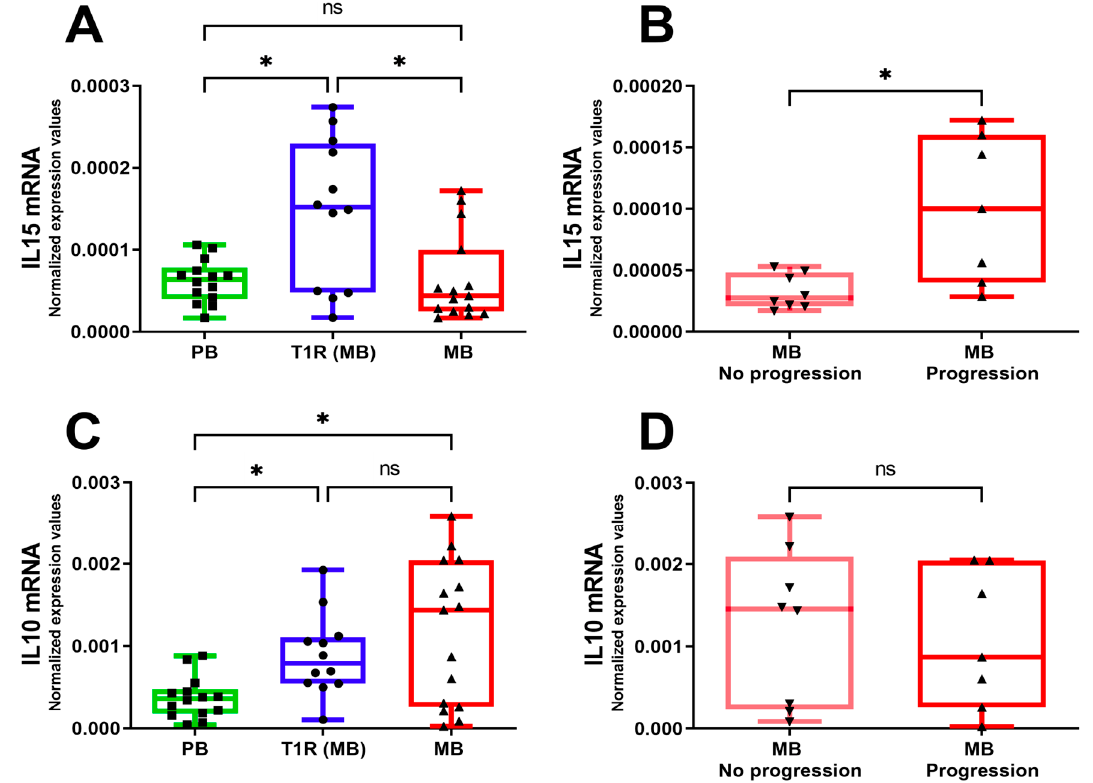
Figure 5. Cytokine mRNA expression profile in PB, MB, and T1R skin lesions. Gene expression of the inflammatory molecule IL-15 ( A ) and anti-inflammatory molecule IL-10 ( C ) were evaluated by real-time PCR in skin lesions of paucibacillary (PB), multibacillary (MB), and reactional (T1R) patients. ( B , D ) MB patients were monitored for 2 years following the start of MDT and were stratified on the basis of the outcome or not of T1R during the follow-up. ( B ) IL-15 mRNA levels. ( D ) IL-10 mRNA levels. Patient data are representative of PB ( n = 14), MB no-progression ( n = 8), MB progression ( n = 7), and T1R ( n = 12). Gene expression data were normalized to GAPDH . Data in the whiskers are the minimum to maximum with all points shown; * p < 0.05 by the Brown–Forsythe and Welch ANOVA tests with Dunnett’s T3 multiple comparisons test ( A , C ) or two-tailed unpaired t -test with Welch’s correction ( B , D ). ns: not significant.